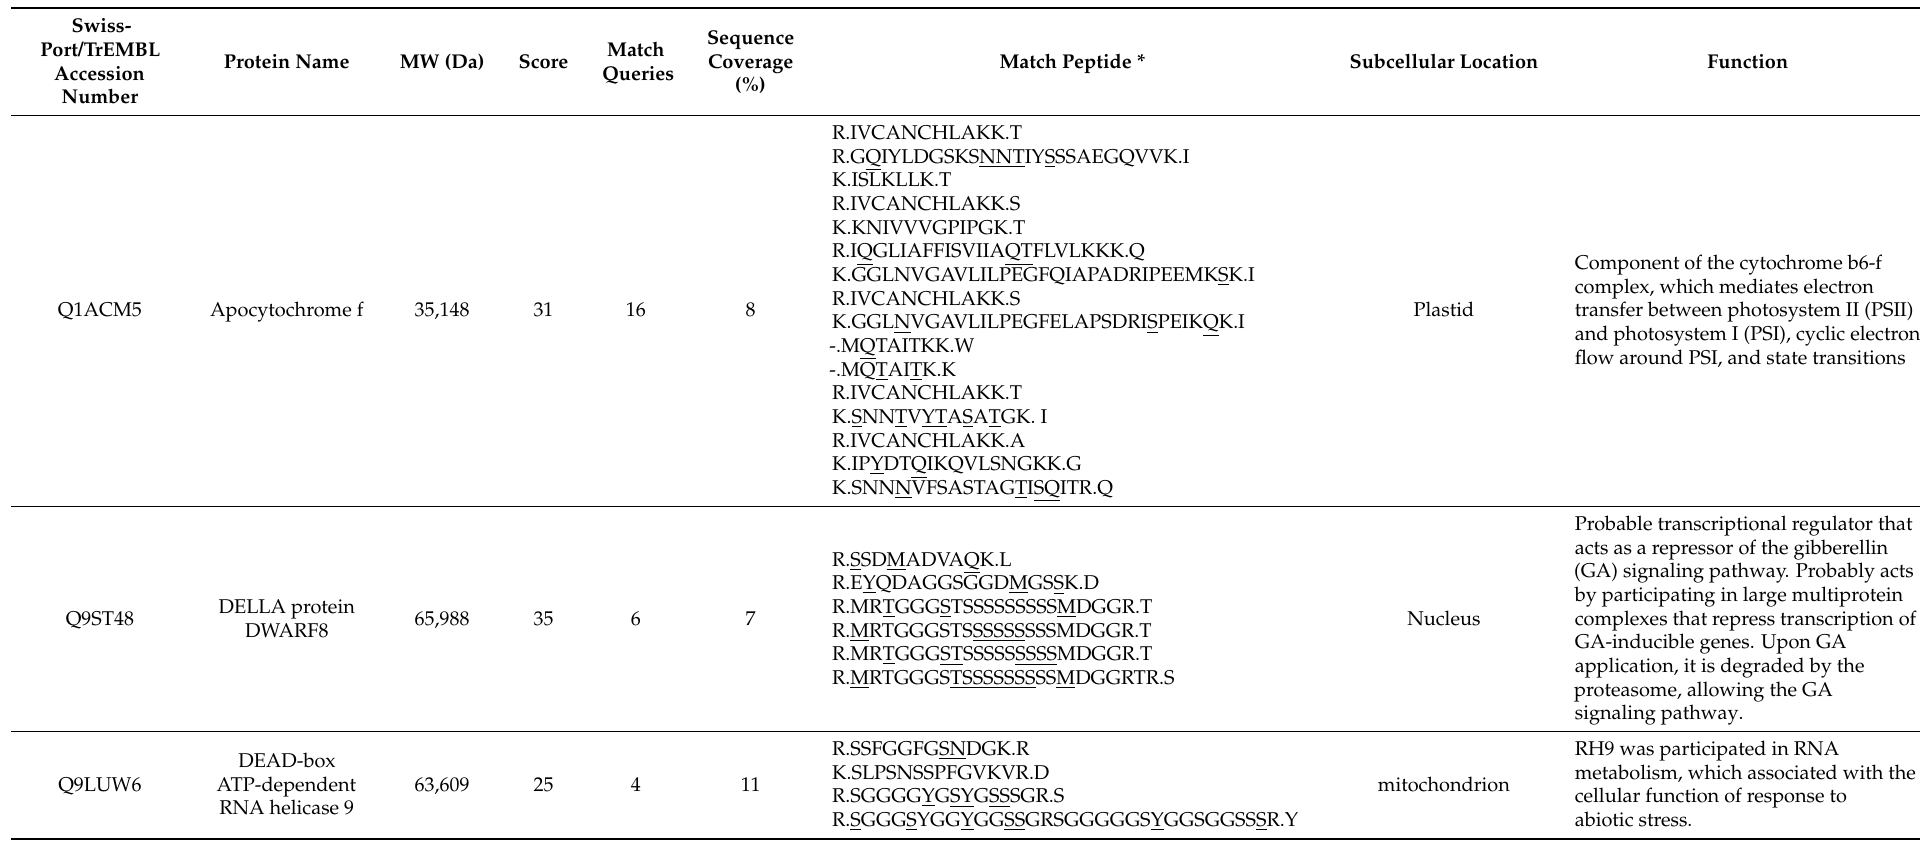
Table 1. After 5 kGy gamma-ray irradiation, the peptide sequence tags, subcellular localization and protein functional classification of six up-regulated proteins with higher confidence levels (at least two unique peptide sequences matched) were